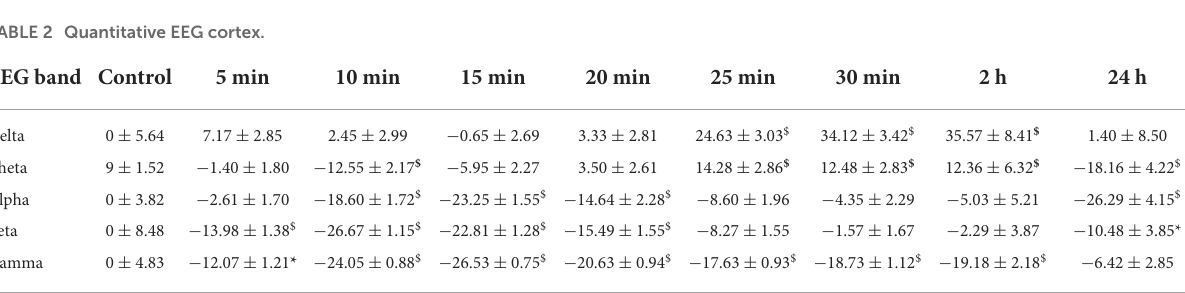
TABLE 2 Quantitative EEG